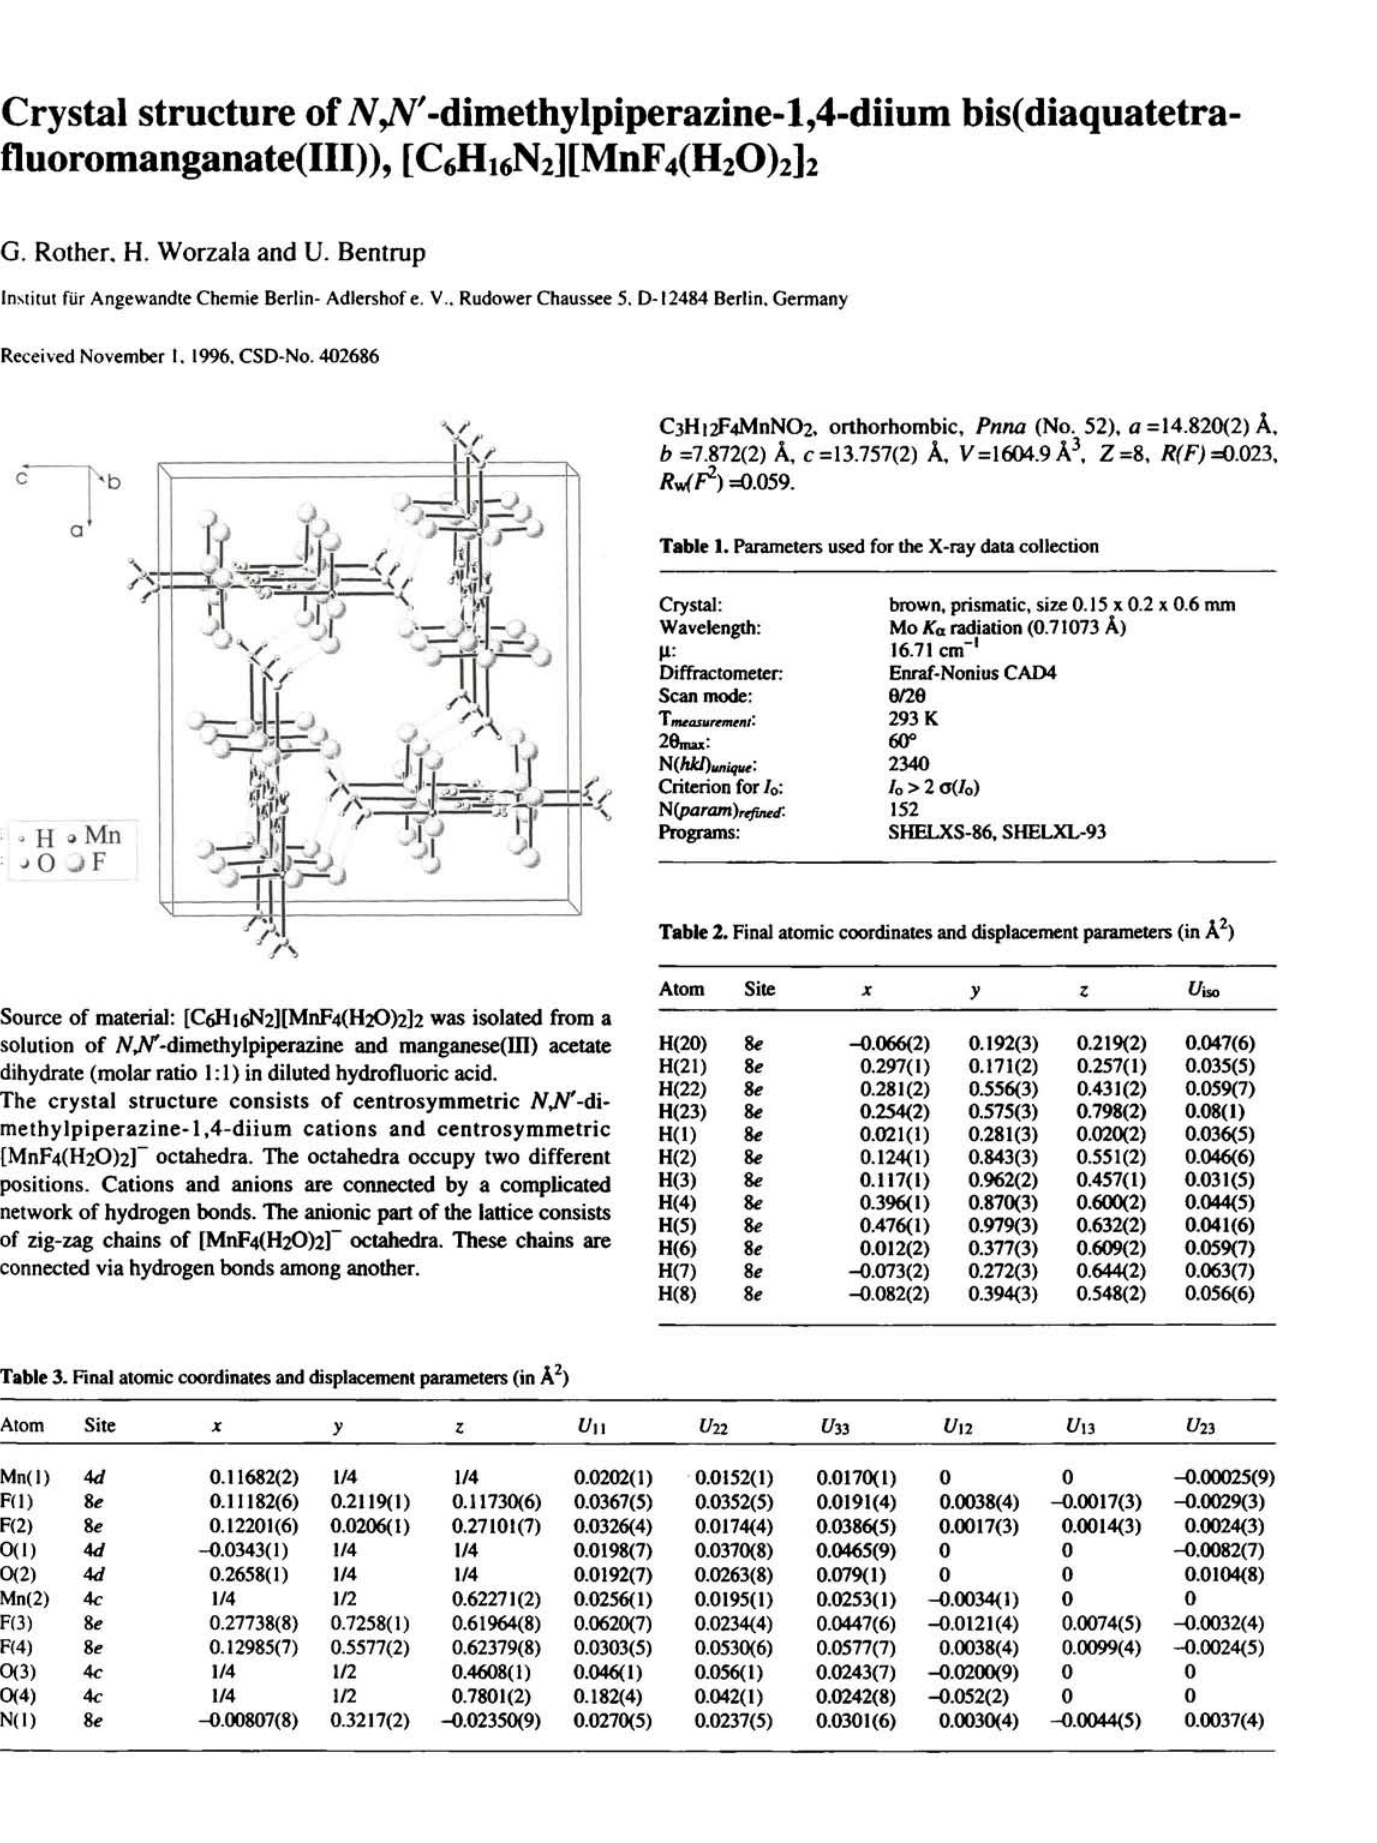
Table 3. Final atomic coordinates and displacement parameters (in A 2 ) Atom